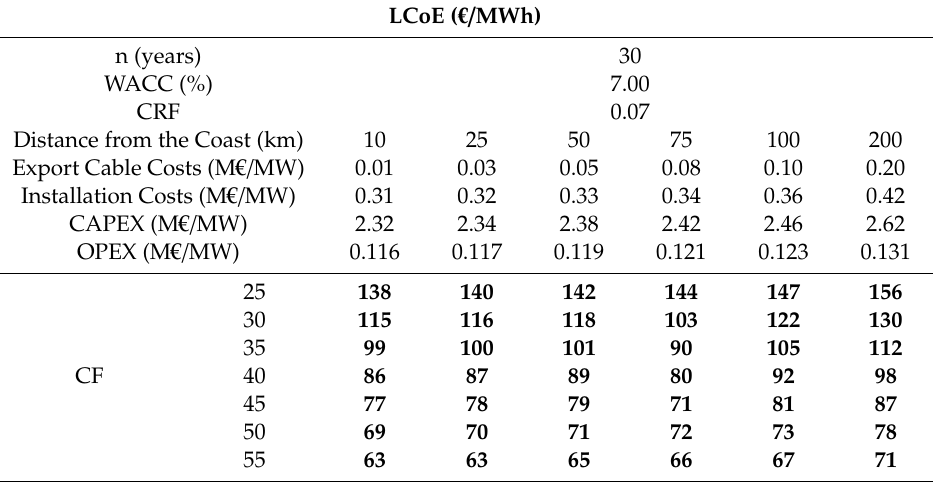
Table 3. LCoEs (in bold in the table) calculated as function of CAPEX, OPEX, and CF. WACC equal to 7%. LCoE ( € / MWh) n (years)